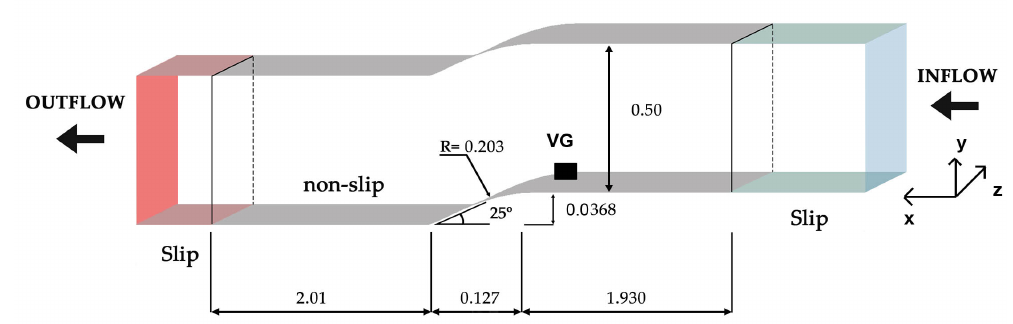
Figure 1. Description of the computational domain representing the extended wind tunnel test section. The domain dimensions are expressed in